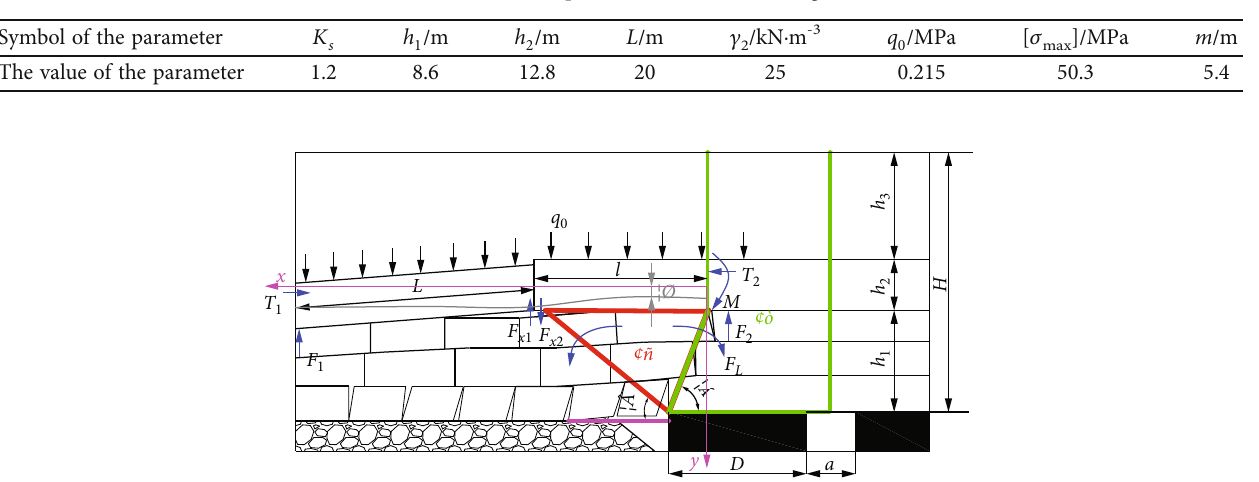
Figure 1: Working face layout diagram and lithology. Table 1: Mechanical parameters of 6105 working face.